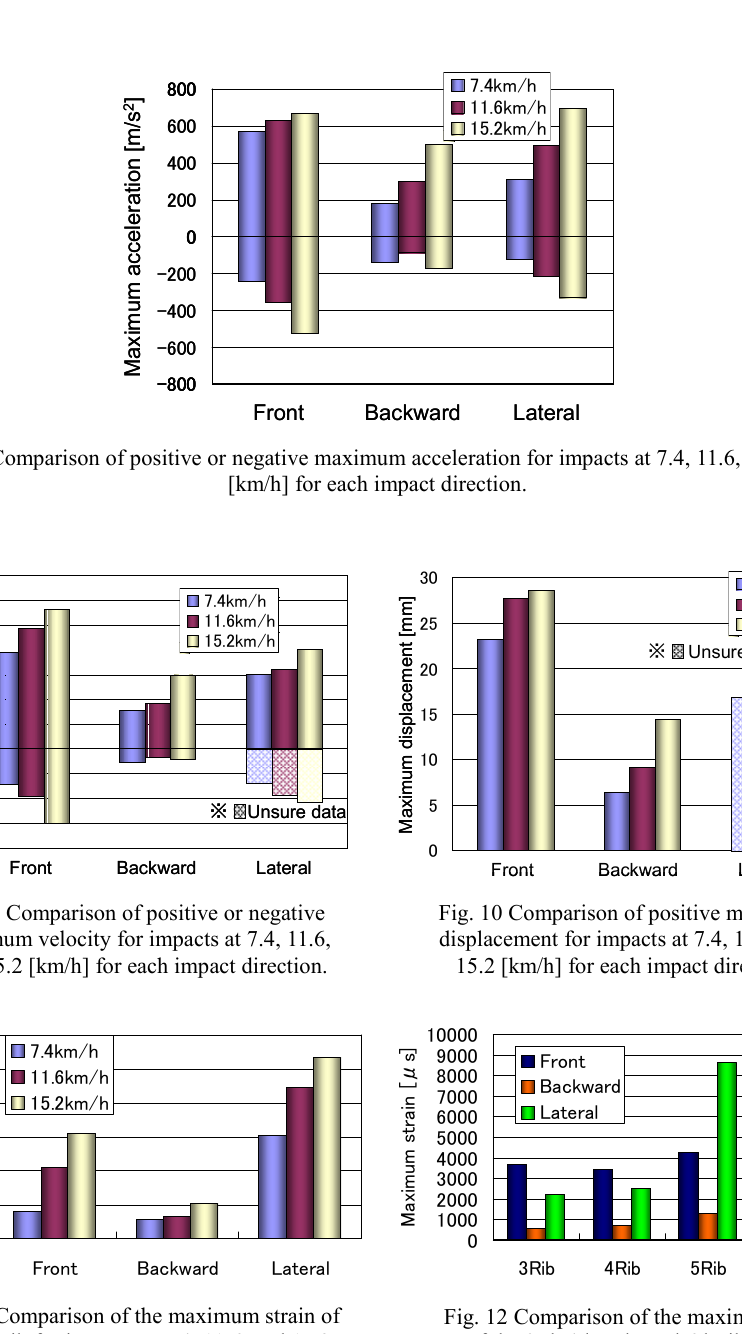
Fig. 11 Comparison of the maximum strain of the 5th rib for impacts at 7.4, 11.6, and 15.2 [km/h] from each impact direction.